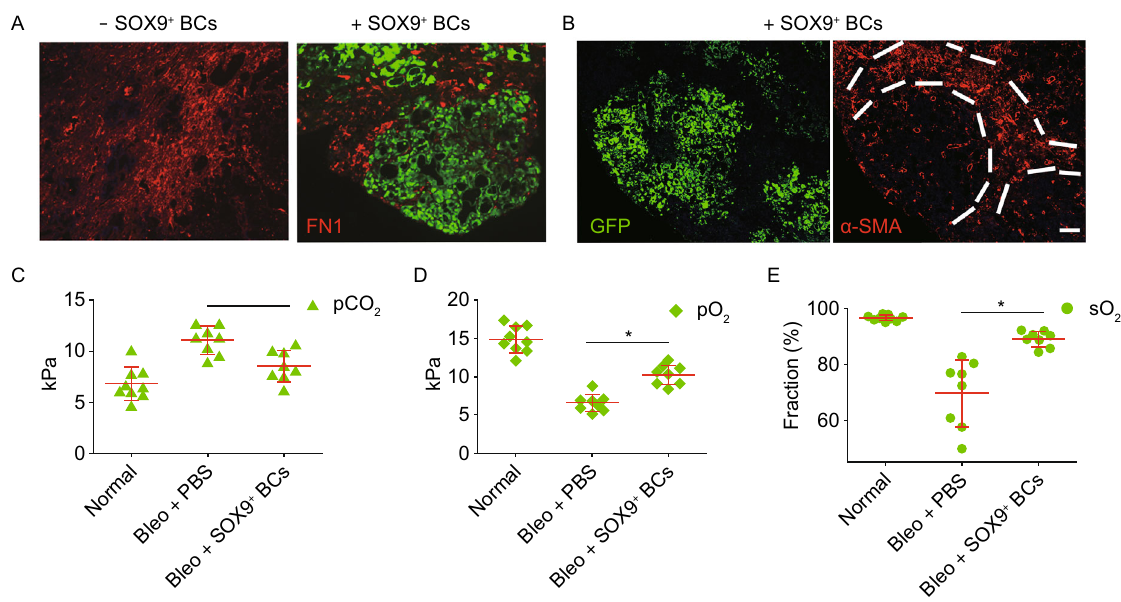
Figure 5. BC transplantation rescued mouse pulmonary function. (A) Injured mouse lung without or with GFP-labeled SOX9 + BCs transplantation by anti-GFP and anti-Fibronectin co-staining. Scale bar, 200 μ m. (B) Left, immuno fl uorescence image of injured mouse lung transplanted with GFP-labeled SOX9 + BCs; right, immunostaining on the same section showing exclusion of α -SMA+ myo fi broblasts from GFP + area. Scale bar, 200 μ m. (C) CO 2 partial pressure of mouse arterial blood before and 1 month after bleomycin-induced injury with or without SOX9 + BCs transplantation. Each dot indicates an individual mouse. (D) O 2 partial pressure of mouse arterial blood 1 month after bleomycin-induced injury with or without SOX9 + BCs transplantation. Each dot indicates an individual mouse. (E) O 2 saturation of mouse arterial blood before and 1 month after bleomycin-induced injury with or without SOX9 + BCs transplantation. Each dot indicates an individual